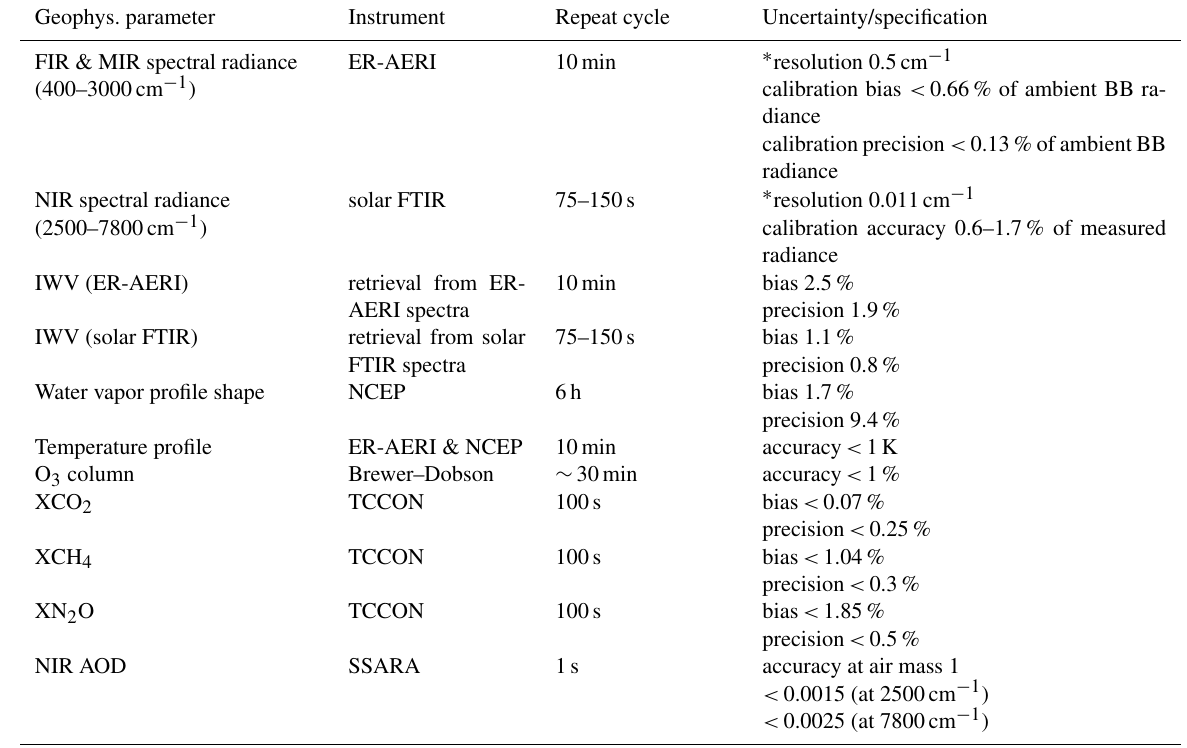
Table 1. Instruments and geophysical parameters measured at the Zugspitze radiative closure experiment. Uncertainties are given for 2 σ confidence.